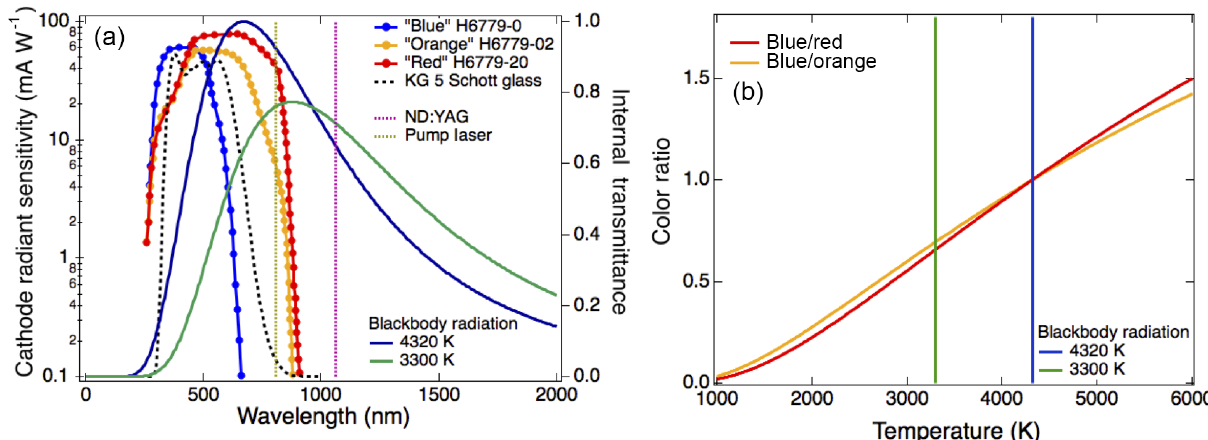
Figure 1. Determination of single particle blackbody temperature from SP2 incandescent detectors. (a) Normalized blackbody curves for T = 4320K (typical of rBC) and T = 3300K (typical of FeO x ) are shown as solid blue and green curves, along with the cathode radiant sensitivity of the PMTs typically used in the SP2, as blue, orange, and red lines and markers. The dashed black line gives the transmissivity of the glass filter used with the red and orange detectors. The yellow dashed line is the wavelength of the pump light, and the maroon dashed line is the wavelength of the Nd:YAG laser. (b) The color ratio as a function of the particle’s characteristic blackbody temperature derived for two different detector configurations (blue:red, blue:orange) is shown, assuming the color ratio is scaled to 1 at